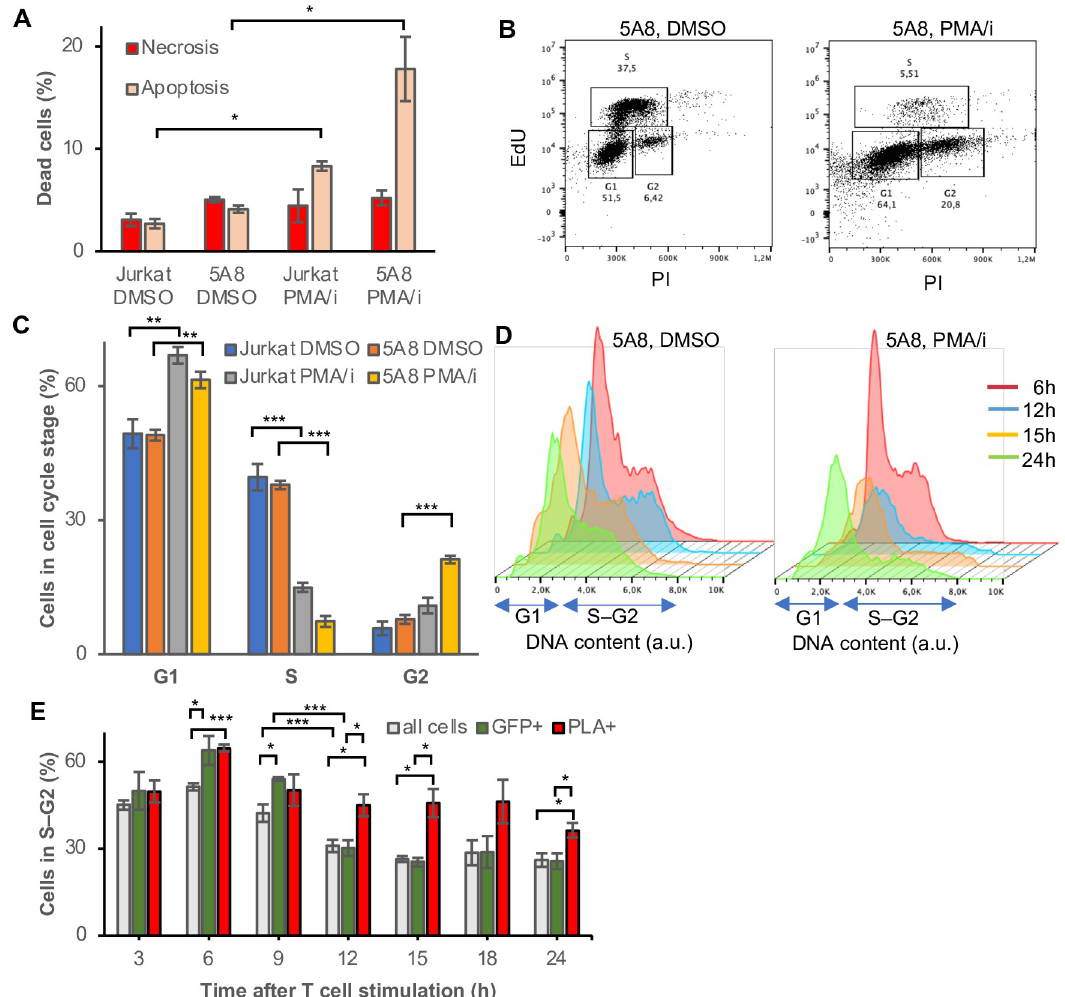
Fig 4. Tat is transiently bound to HIV-1 promoter in all cell cycle stages. (A) Apoptosic and necrotic cell populations determined by PI/Annexin V staining and flow cytometry in J-lat 5A8 cells and parental Jurkat cells after 16 h T cell stimulation with PMA/i. (B) Incorporation of thymidine homolog EdU during a 1 h pulse 16 h after PMA/I stimulation. (C) (D) DNA content was calculated from DAPI intensity in unstimulated cells (DMSO) (left) or stimulated cells (PMA/i) (right) from the micrographs at 9–24 h PMA/i exposure. (D) Percentage of cells in S–G2 phase of the cell cycle at different time points after T cell stimulation. All cells in grey, GFP + cells in green, and Tat-ZFP3 PLA + cells in red, n = 5, error bars represent s.e.m., Student t-test p-values � p < 0.05, �� p < 0.01, ��� p <